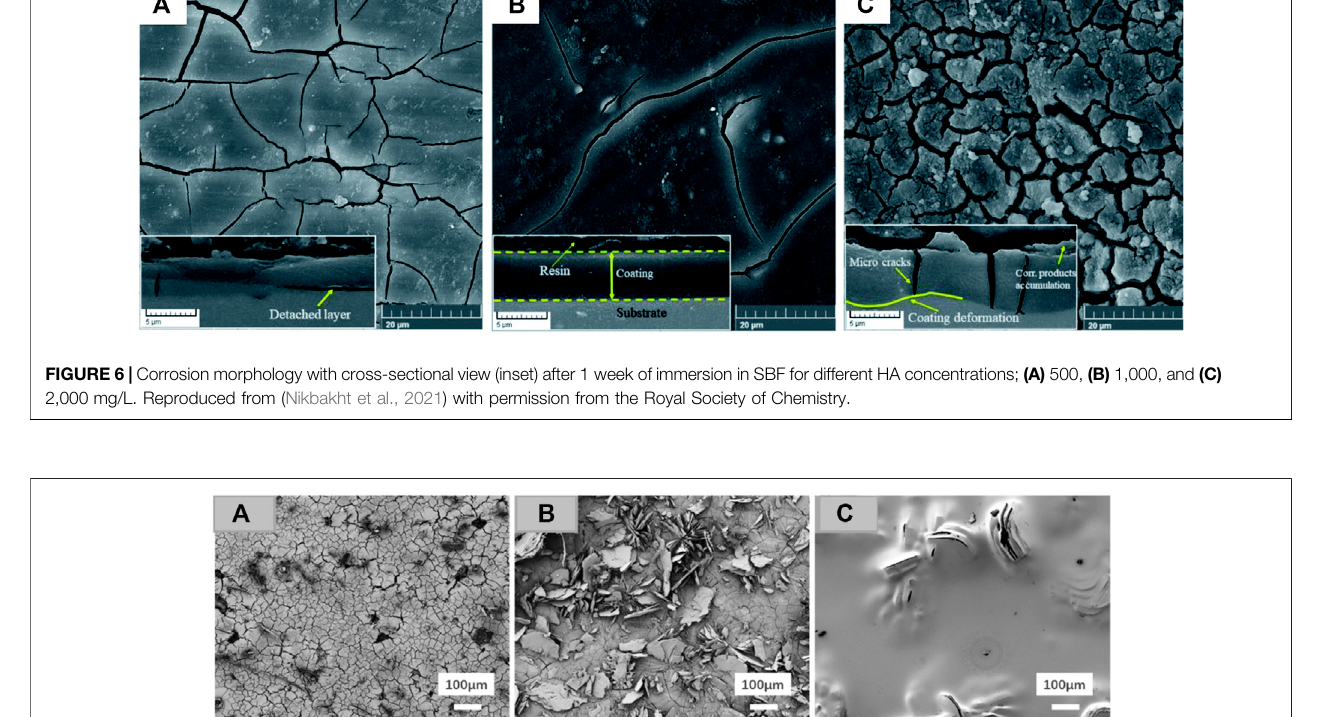
FIGURE7| SEMmorphology after 72 hofimmersion; (A) uncoated Mg, (B) pre-treated DAHP,and (C) spin coated DAHP/PEI60.Reprinted withpermission from (Yang et al., 2019b), Copyright 2019, American Chemical Society.